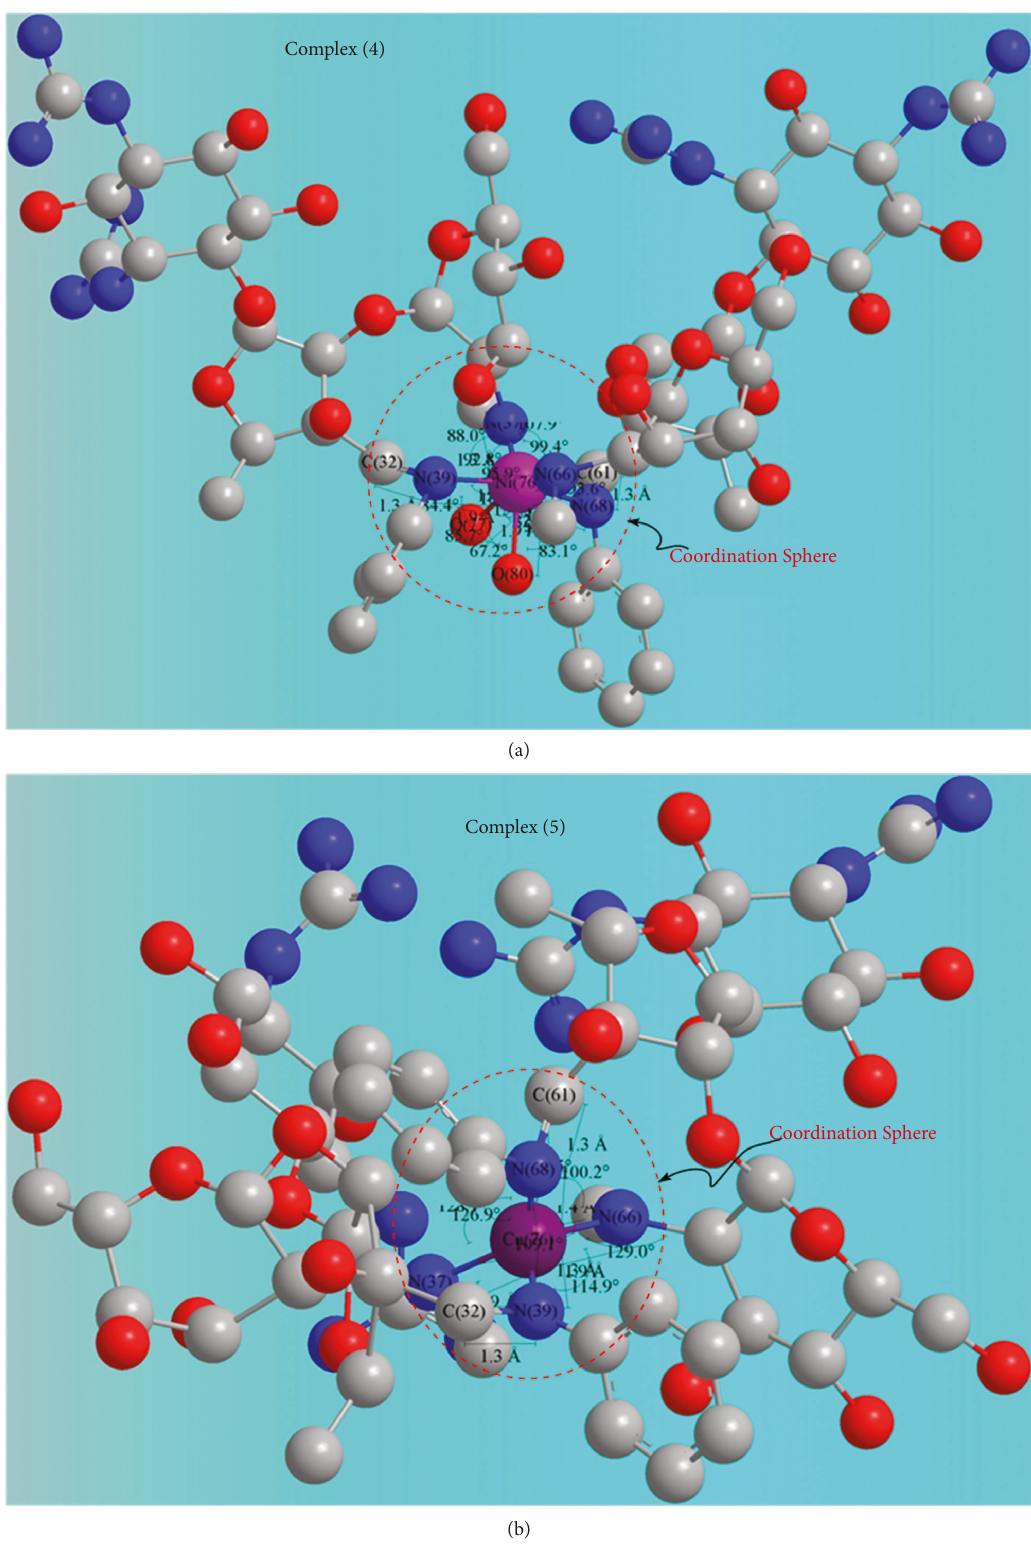
Figure 5: 3D-optimized structures of (a) complex ( 4 ) and (b) complex ( 5